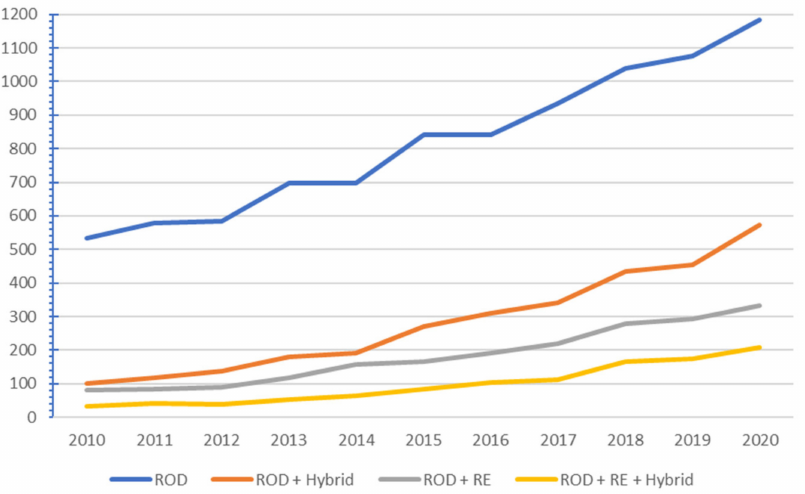
Figure 5. Number of publications in the Scopus database per year in the last 10 years for different searches, in which ROD = Reverse Osmosis Desalination and RE = Renewable